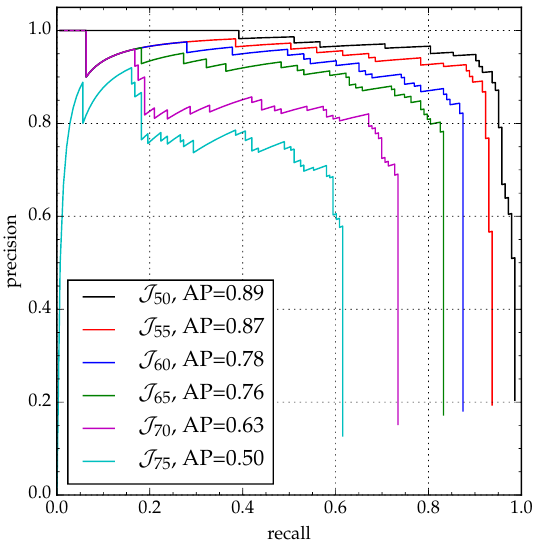
Figure 4. Precision–recall curves for the tree stem detection algorithm.